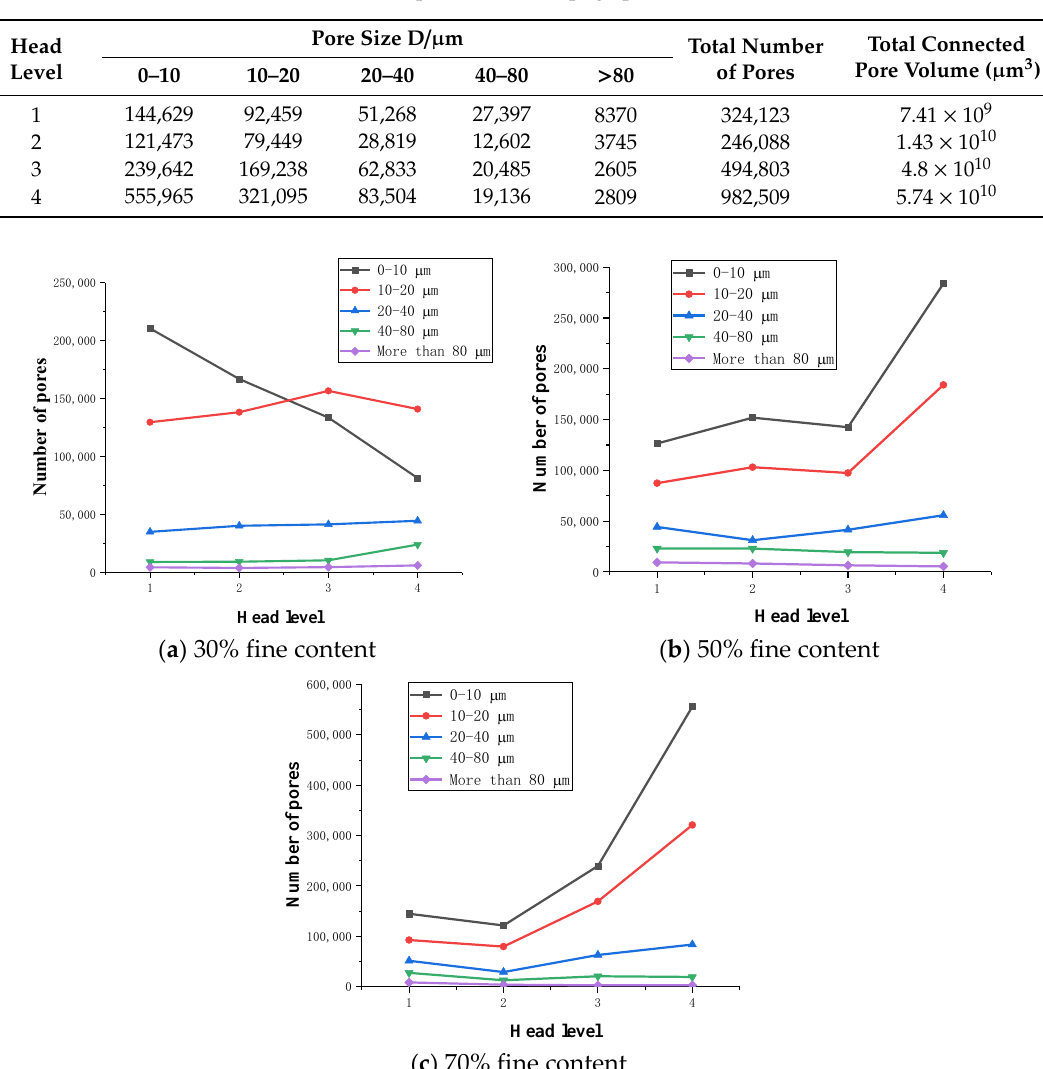
Figure 8. Variation in the pore number. ( a ) 30% fine content; ( b ) 50% fine content; ( c ) 70% fine content. As seen from the above chart: As seen from the above